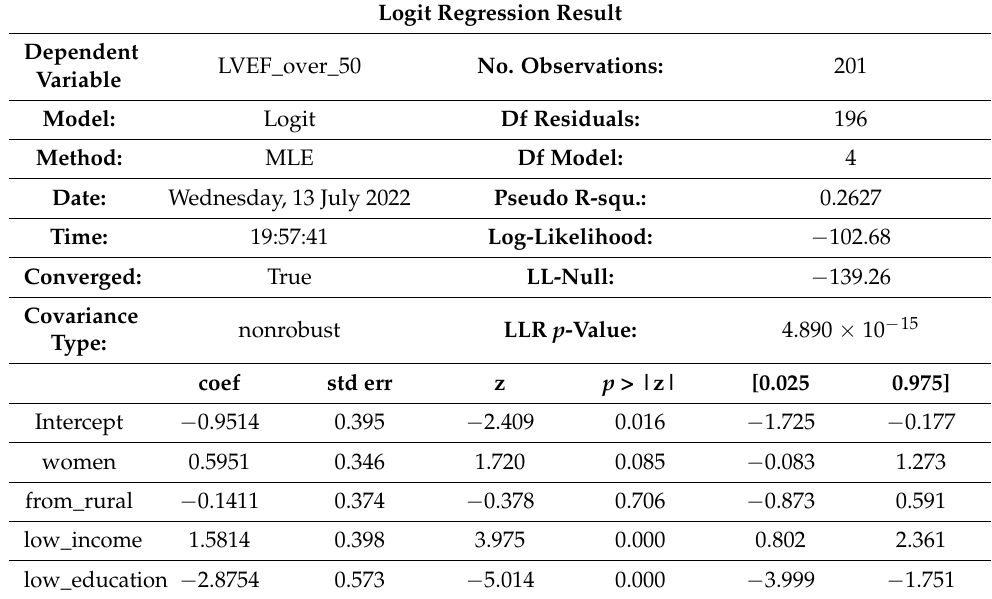
Table 4. Logistic regression output for social variables. Logit Regression Result